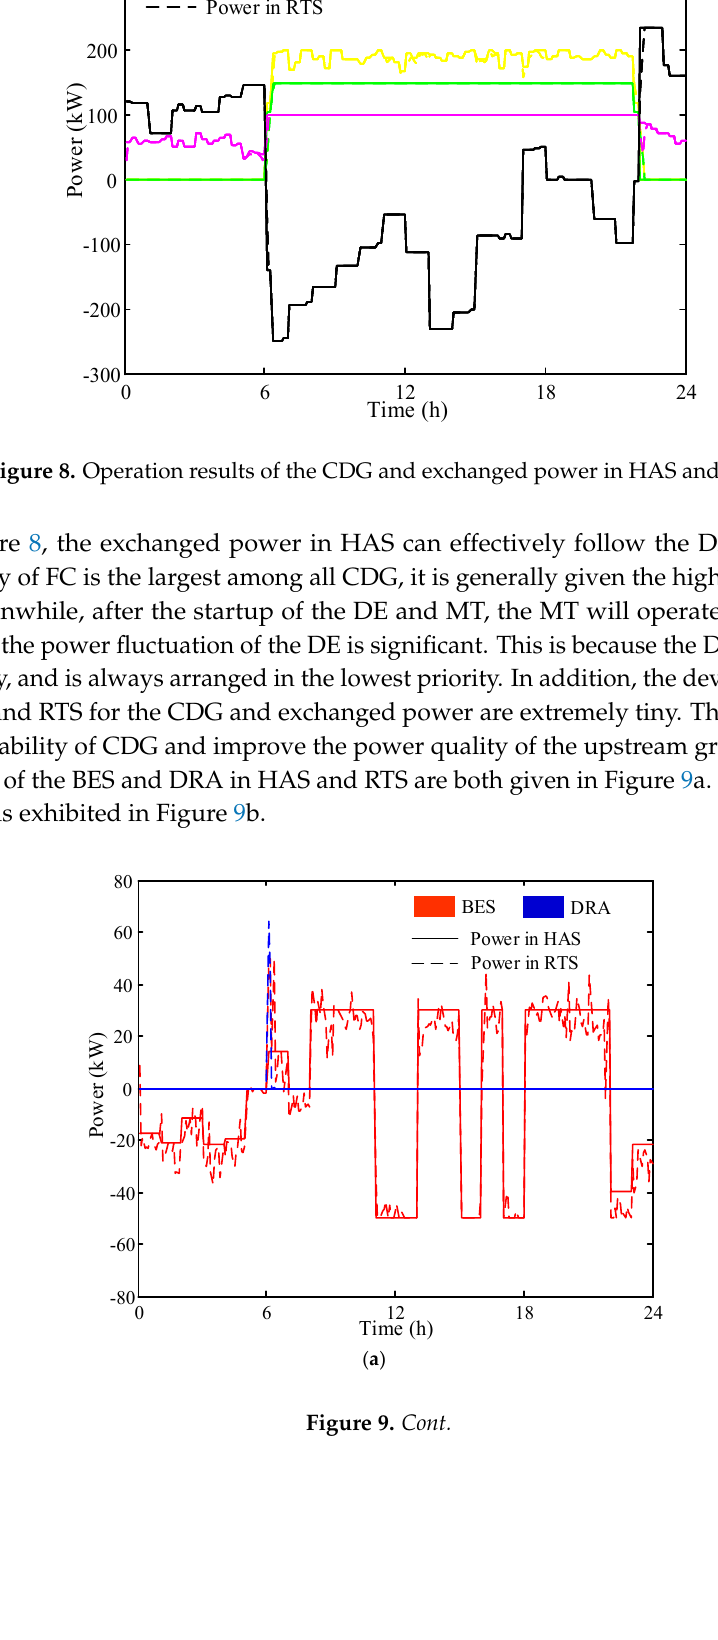
Figure 7. Decision variables of the DAS that are passed to the HAS: ( a ) Exchanged power with main grid as well as the power of BES and DRA; ( b ) Operation variable of CDG.